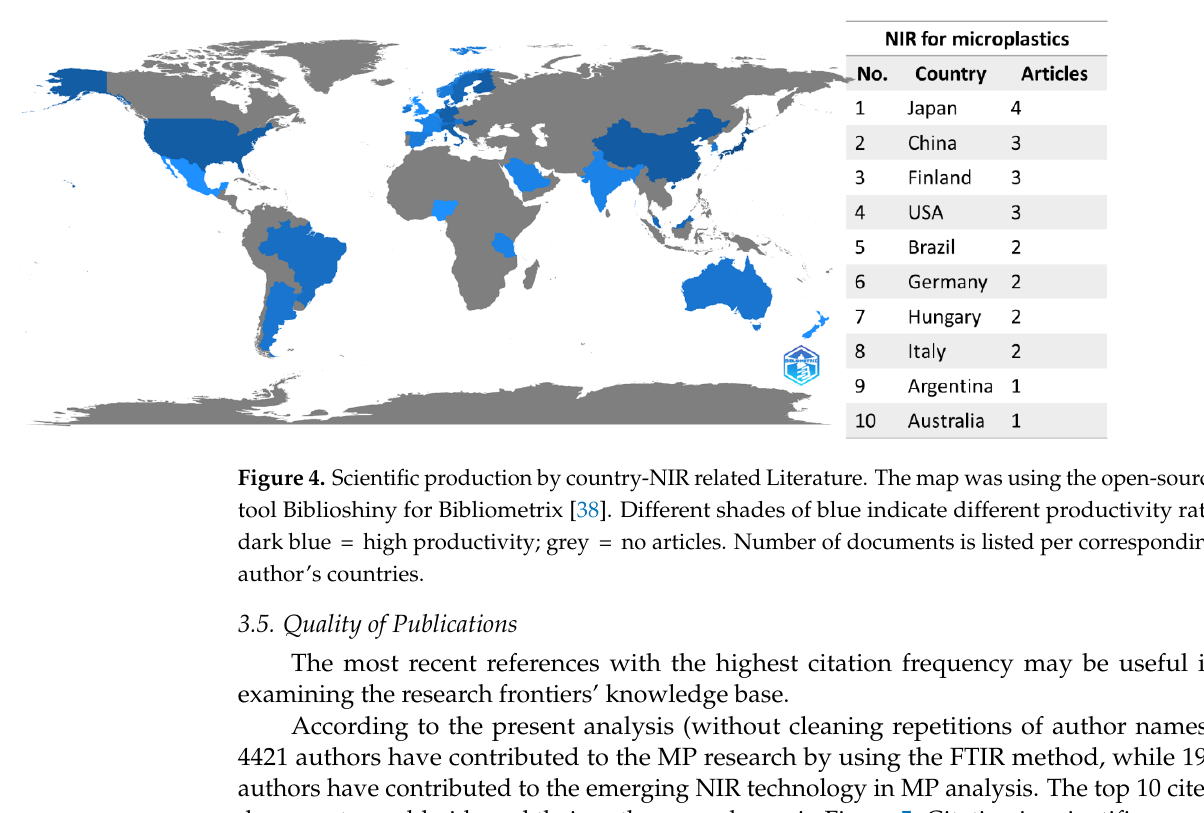
Figure 3. Scientific production by country-FTIR related Literature. The map was generated using the open-source tool Biblioshiny for Bibliometrix [38]. Different shades of blue indicate different productivity rate: dark blue = high productivity; grey = no arti cles. Number of documents is listed per corresponding author’s countries.